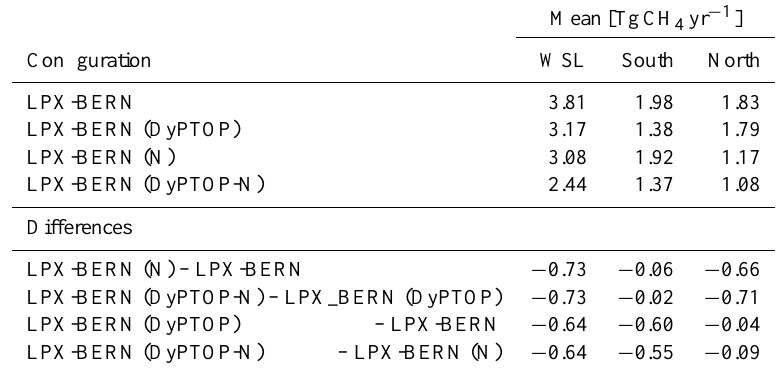
Table 6. Mean CH 4 emissions from LPX-BERN, 1993–2010, for the entire WSL and the south and north halves of the